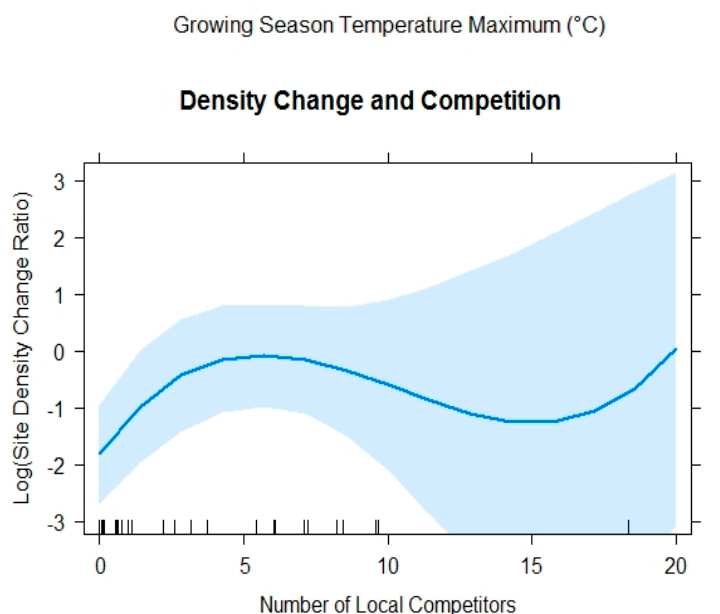
Figure 7. Plotted fixed effects of the best model for log(Site Density Change Ratio) ~ Growing Season Temperature Maximum 3 + Number of Local Competitors 3 + random(Unit) with confidence interval = 0.95 in light blue.